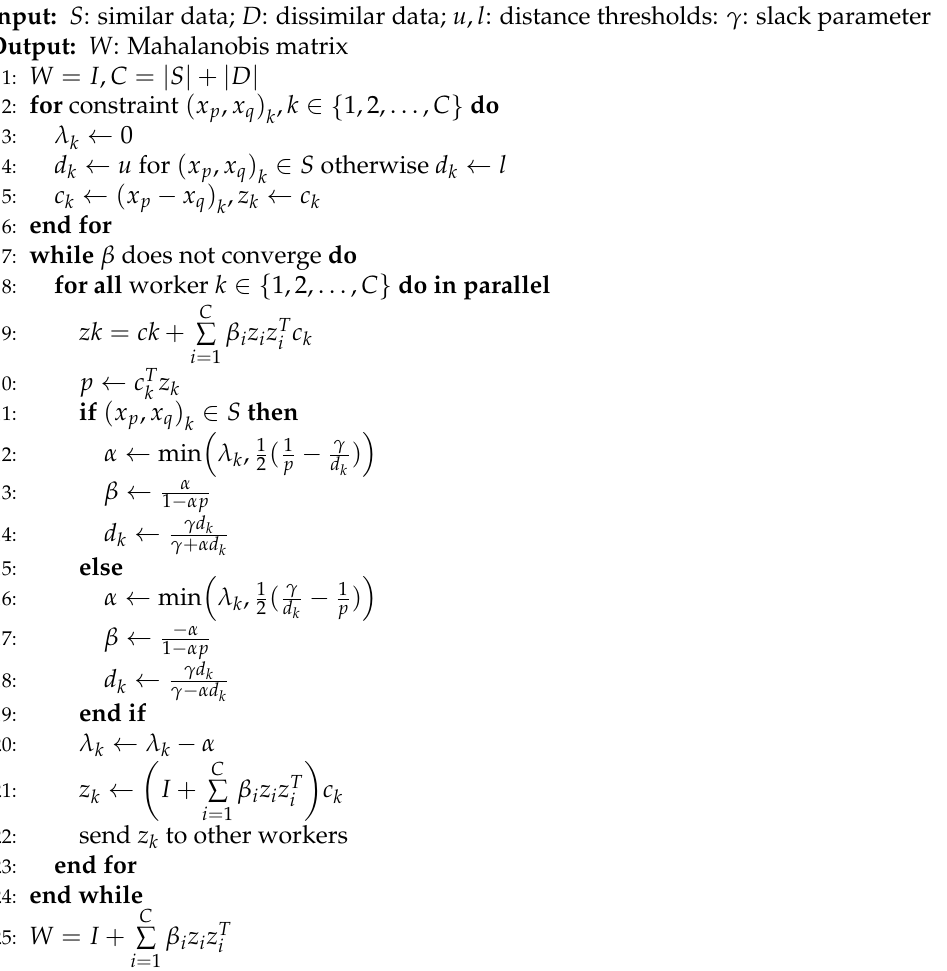
Algorithm 1 Parallel Metric